Question: Condense the content of this figure into a single sentence.
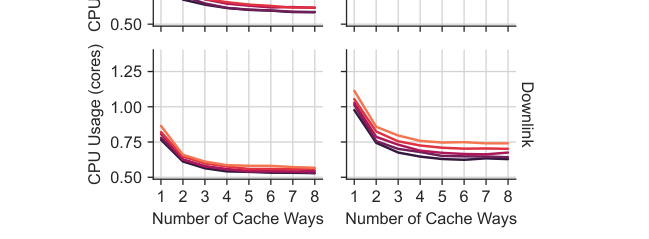
Answer: Computing usage as a function of the LLC allocated cache ways for different SNR and in UL and DL.